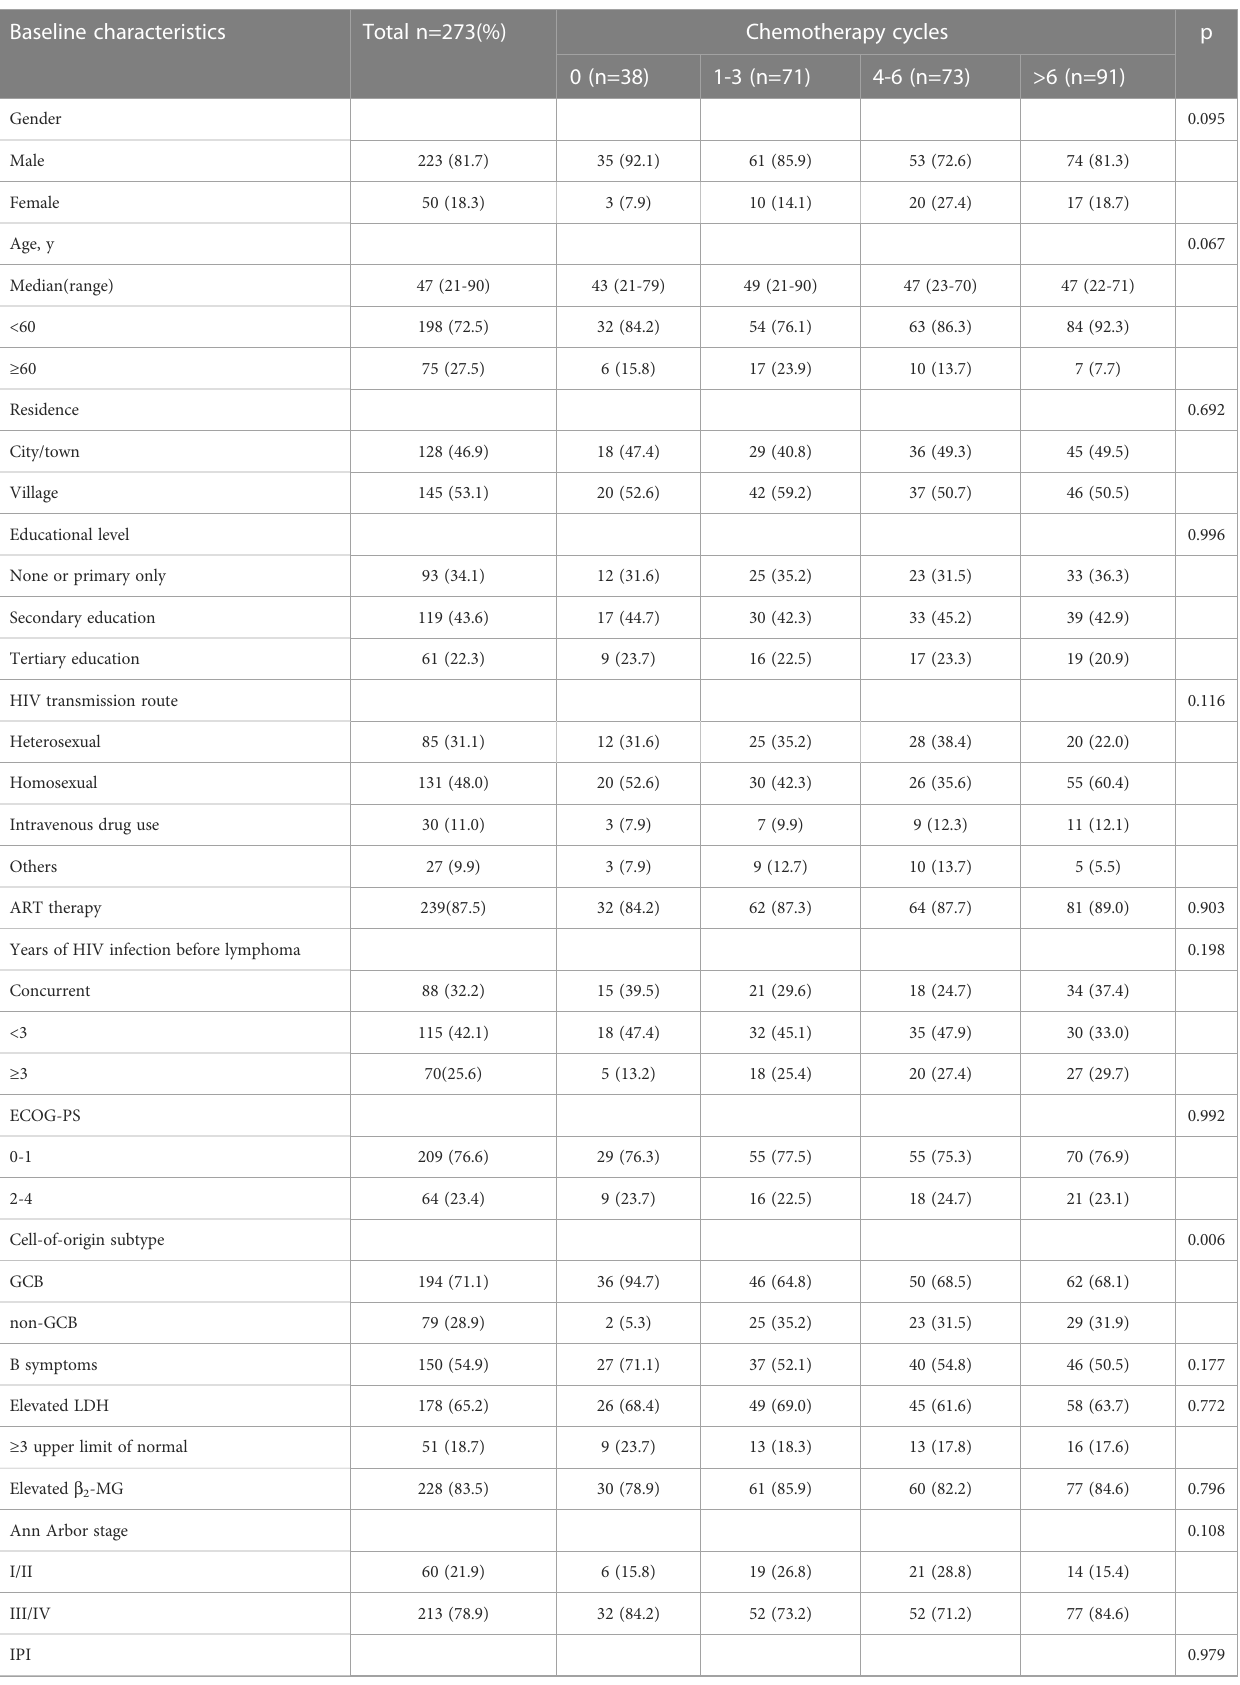
TABLE 1 Baseline clinical characteristics of